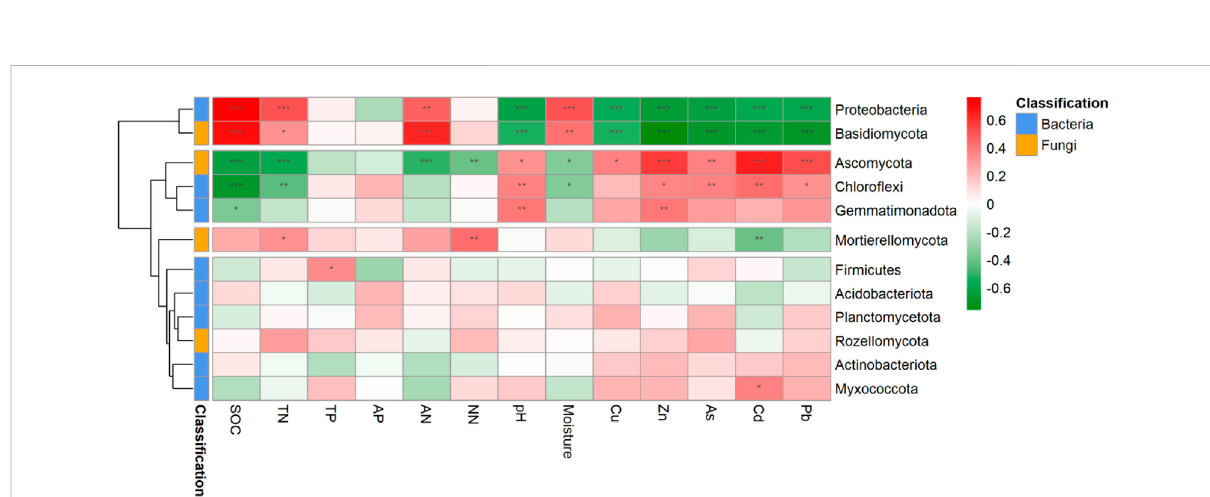
FIGURE 5 Correlation heat maps for the correlation between community composition and environmental variables at the phylum level. The left dendogram linkages represent clustering results of these microbial groups. SOC, soil organic carbon; TN, total nitrogen; TP, total phosphorus; AP, available phosphorus; AN, ammonium nitrogen; NN, nitrate nitrogen. *, < 0.05; **, < 0.01; ***, <